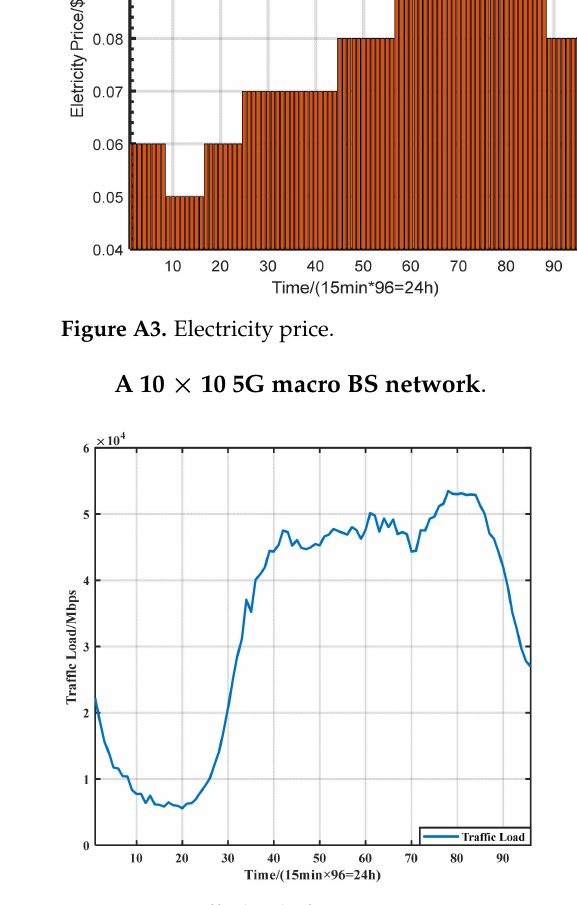
Figure A4. Traffic load of a 10 × 10 5G macro BS network.